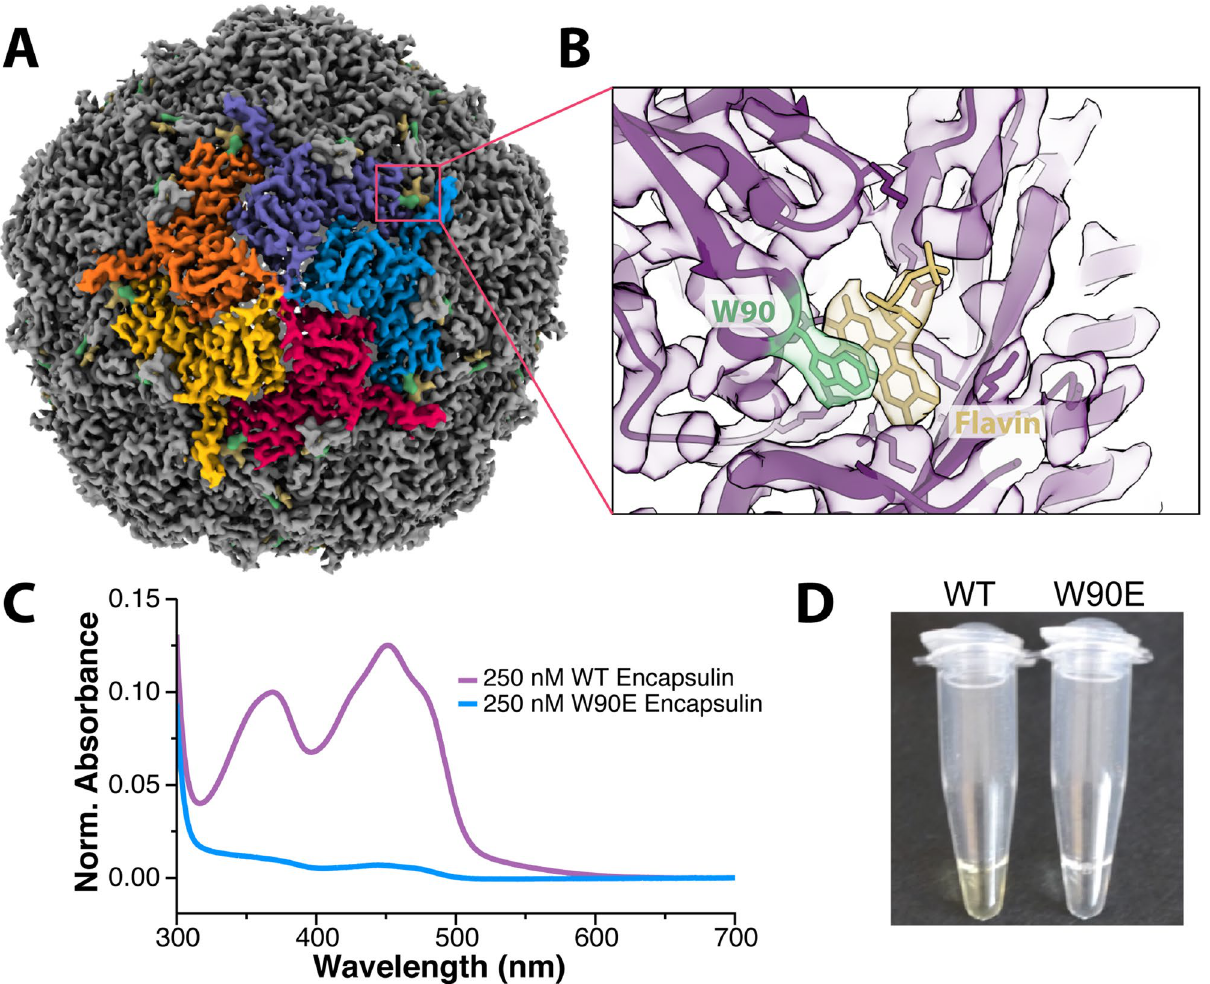
Figure 2. Structural determination confirms the presence of a flavin coordinated with W90. ( A ) Cryo-EM structure of the T. maritima encapsulin determined at 3.3 Å resolution. ( B ) Zoomed-in view of a portion of the density map and corresponding atomic model showing the flavin density (in yellow) next to the tryptophan at position 90 (W90, in green). ( C ) Absorbance spectra of WT encapsulin (purple) and W90E (blue). ( D ) Color difference between wildtype and mutant W90E encapsulins after purification, protein concentration identical between the two